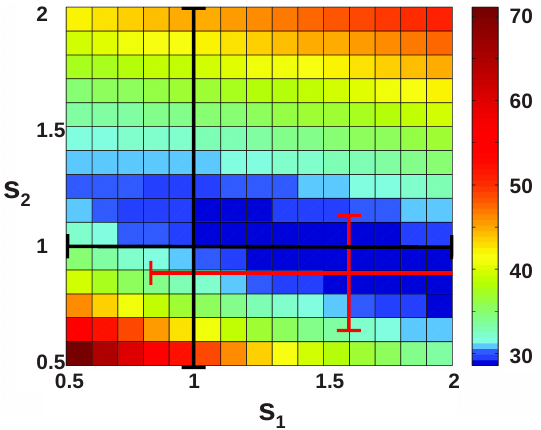
s s Fig. 6. χ 2 as a function of 1 and 2 , as given in Eq. (9). The inferred global minimum is shown in red together with the total error due to noise error of the retrieval. The corresponding JPL-2011 values are given in black.